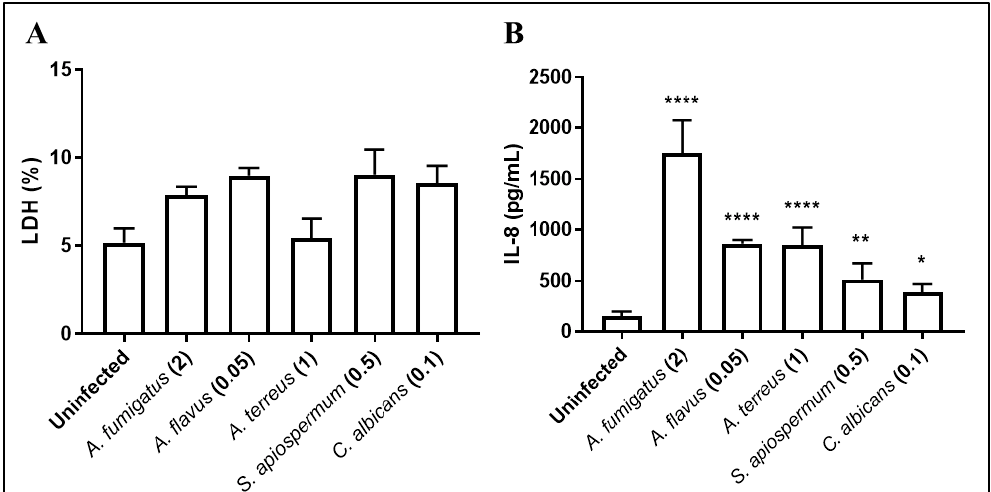
Figure 2. Cytotoxicity of A. fumigatus , A. flavus , A. terreus , S. apiospermum and C. albicans , and inflammatory response of BEC, following 15 h of infection ( A ). IL-8 production is expressed as pg/mL. Numbers in parentheses indicate MOI used for cell infections ( B ). Each histogram is compared with uninfected group and represents the mean ± SEM of 3 independent experiments, * p < 0.05; ** p < 0.01; **** p < 0.0001 (ANOVA Bonferroni).